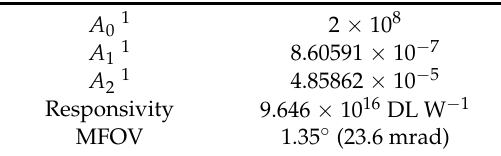
Table 3. Measured Parameters.